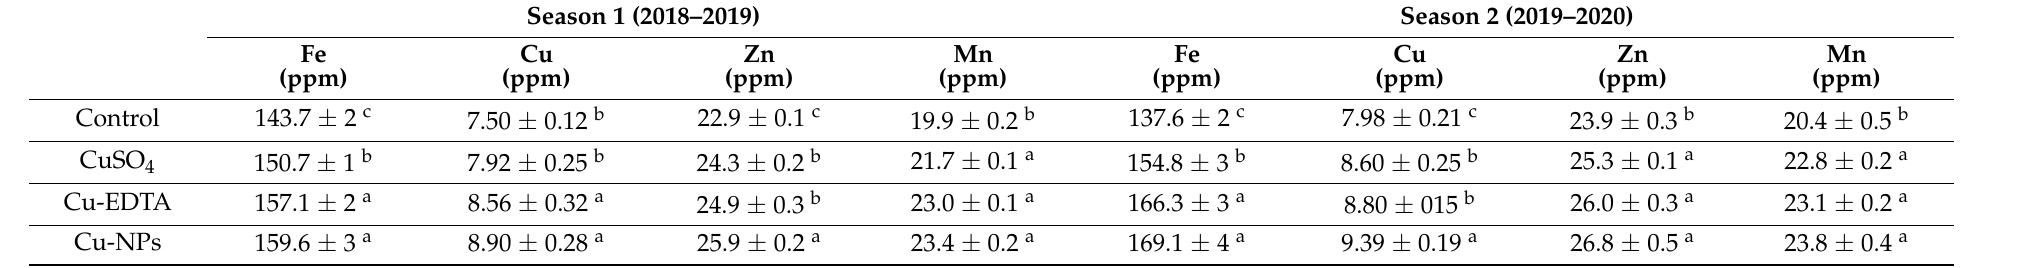
Each value represents the mean ± standard error. Values with different letters show significant differences at p ≤ 0.05 (Duncan’s Test). Table 8. Effect of different sources of Cu on phytochemical contents of onion in two seasons (2018/2019 and 2019/2020).